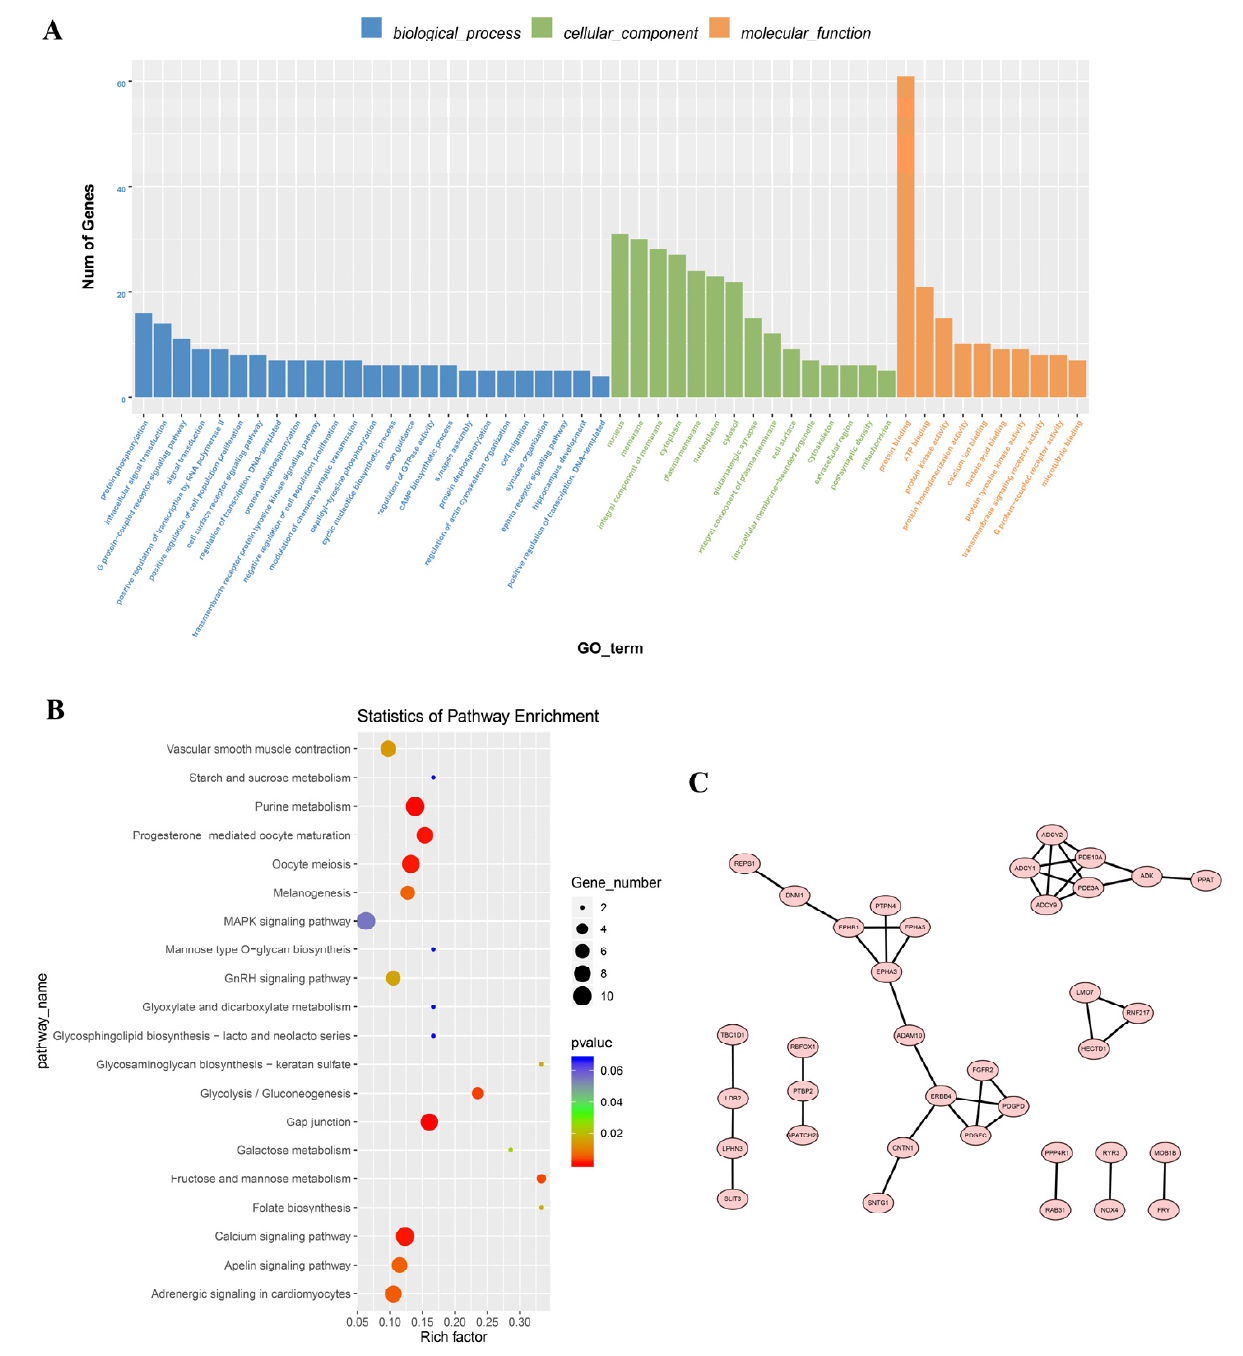
Figure 3. Enrichment of the differentially expressed circRNAs. ( A ) Classification of the parental genes of the differentially expressed circular RNAs based on GO functions. The top 10, 15, and 25 terms in molecular functions, cellular components, and biological processes are displayed, respectively. ( B ) The top 20 enriched KEGG pathways of the parental genes of the circular RNAs with differential expression. ( C ) PPI network for the parental genes of the differentially expressed circular RNAs.